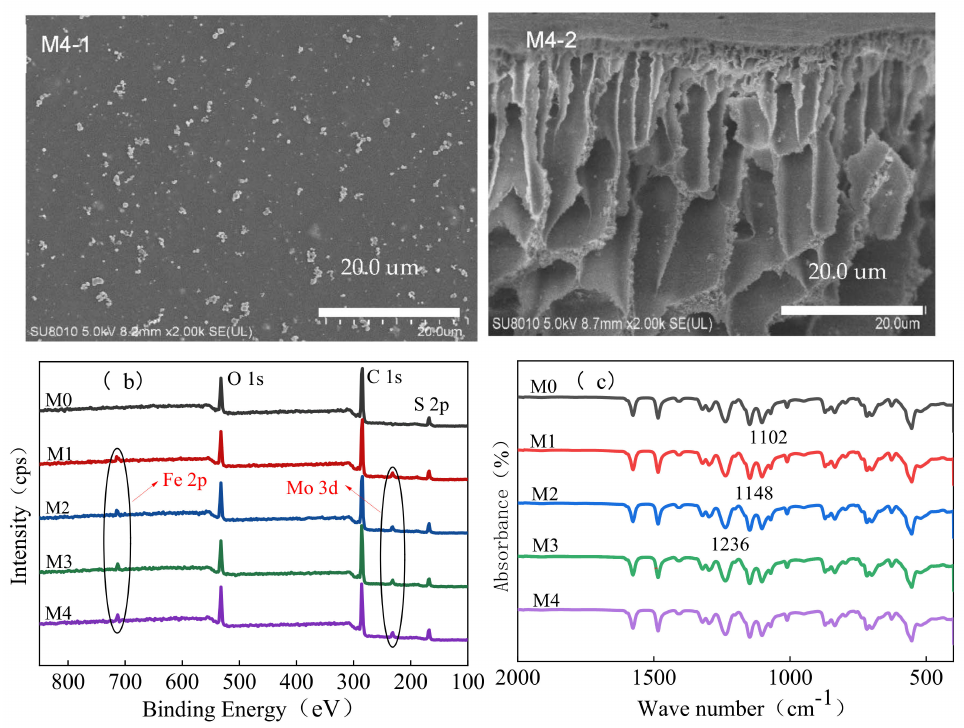
Figure 3. Characterizations of MoS 2 -FeOOH/PES composite membranes ( a ) SEM images; ( b ) XPS spectra; and ( c ) infrared spectra.